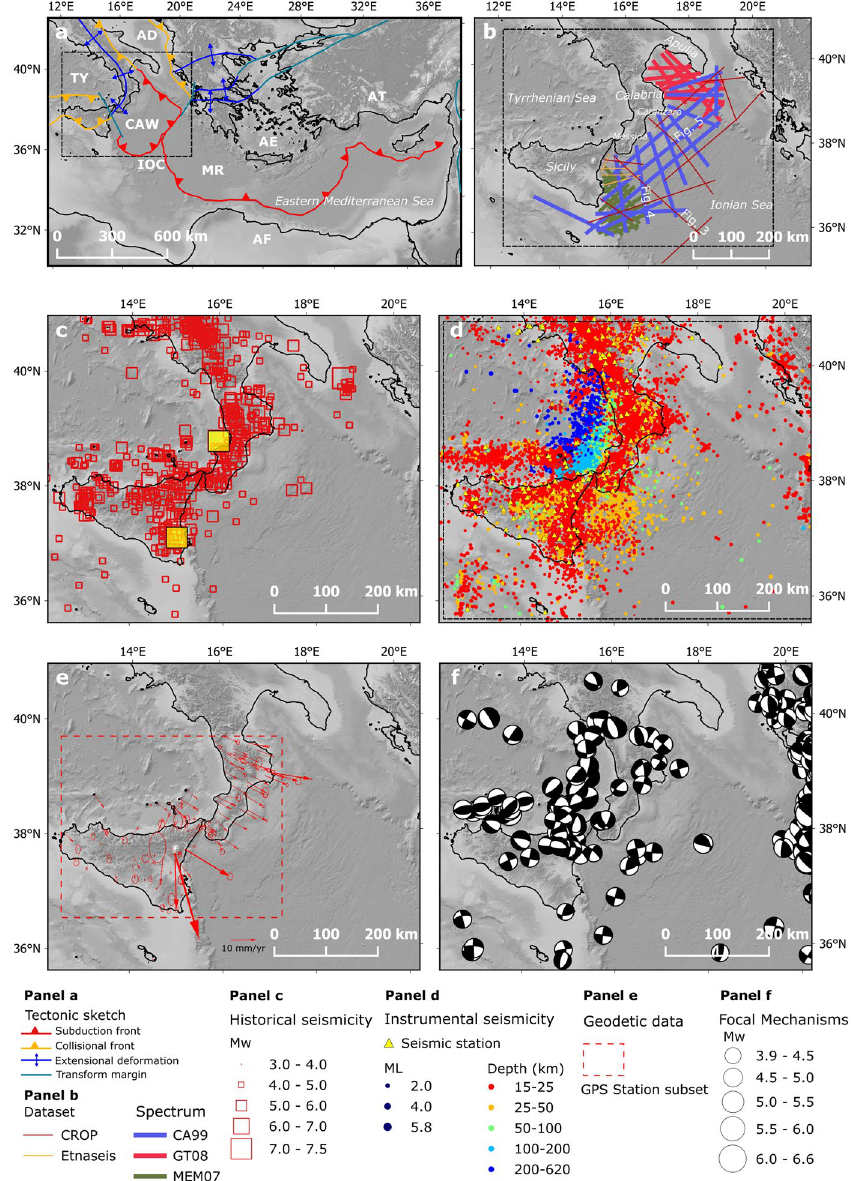
Figure 1. Map of the study area. Panel a – Tectonic sketch of the Eastern Mediterranean region; AF: African plate, AE: Aegean plate, AT: Anatolian plate, EU: Eurasian plate, AD: Adria microplate, CAW: Calabrian accretionary wedge; IOC: Ionian oceanic crust, MR: Mediterranean ridge, TY: Tyrrhenian Sea. The dashed rectangle shows location of Panel b. Panel b - Dataset used in this work. Seismic profiles from: CROP Project (http://www.crop.cnr.it/front-page_EN), Spectrum (http://www.spectrumgeo.com/ provided under confidentiality agreement CA60), Etnaseis survey 42 . Panel c – Historical seismicity from CPTI15 69 . Panel d – Instrumental seismicity from the Italian Seismological Instrumental and Parametric Database 68 , earthquake plotted are recorded in the time period 2005–2016. Panel e – Velocity field from continuous GPS station in the 1998–2009 time span for Sicily and Calabria plotted with a fixed Africa ref. 70. Velocity ellipses represent 1-sigma confidence errors. Panel f – Regional Centroid Moment Tensor solution 71 . Topo-bathymetric relief (Panels a-f) is obtained from SRTM30_PLUS 72 . Coastlines are from the European Environmental Agency